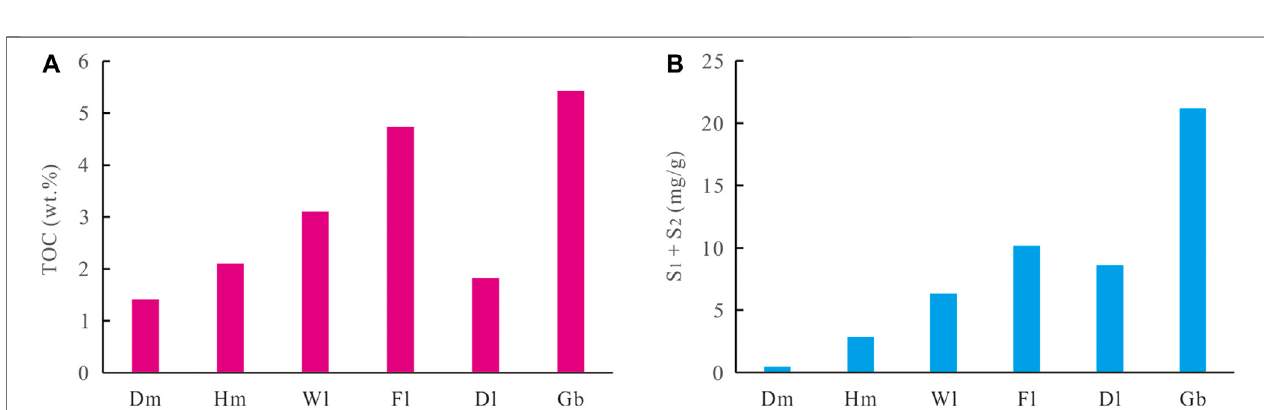
FIGURE 4 | Average TOC (A) and S 1 +S 2 (B) of shale samples with different lithofacies.